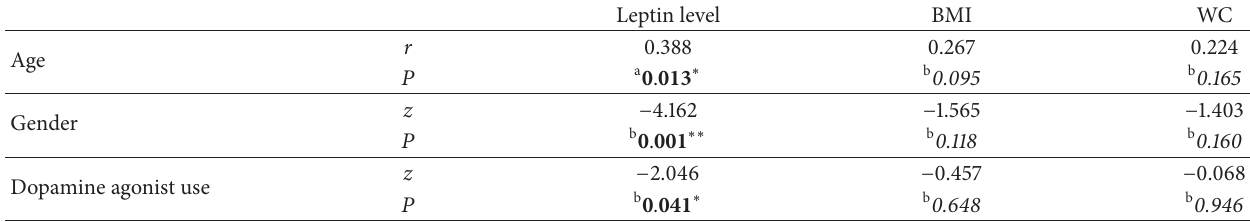
a Spearman correlation analysis. b Mann-Whitney 𝑈